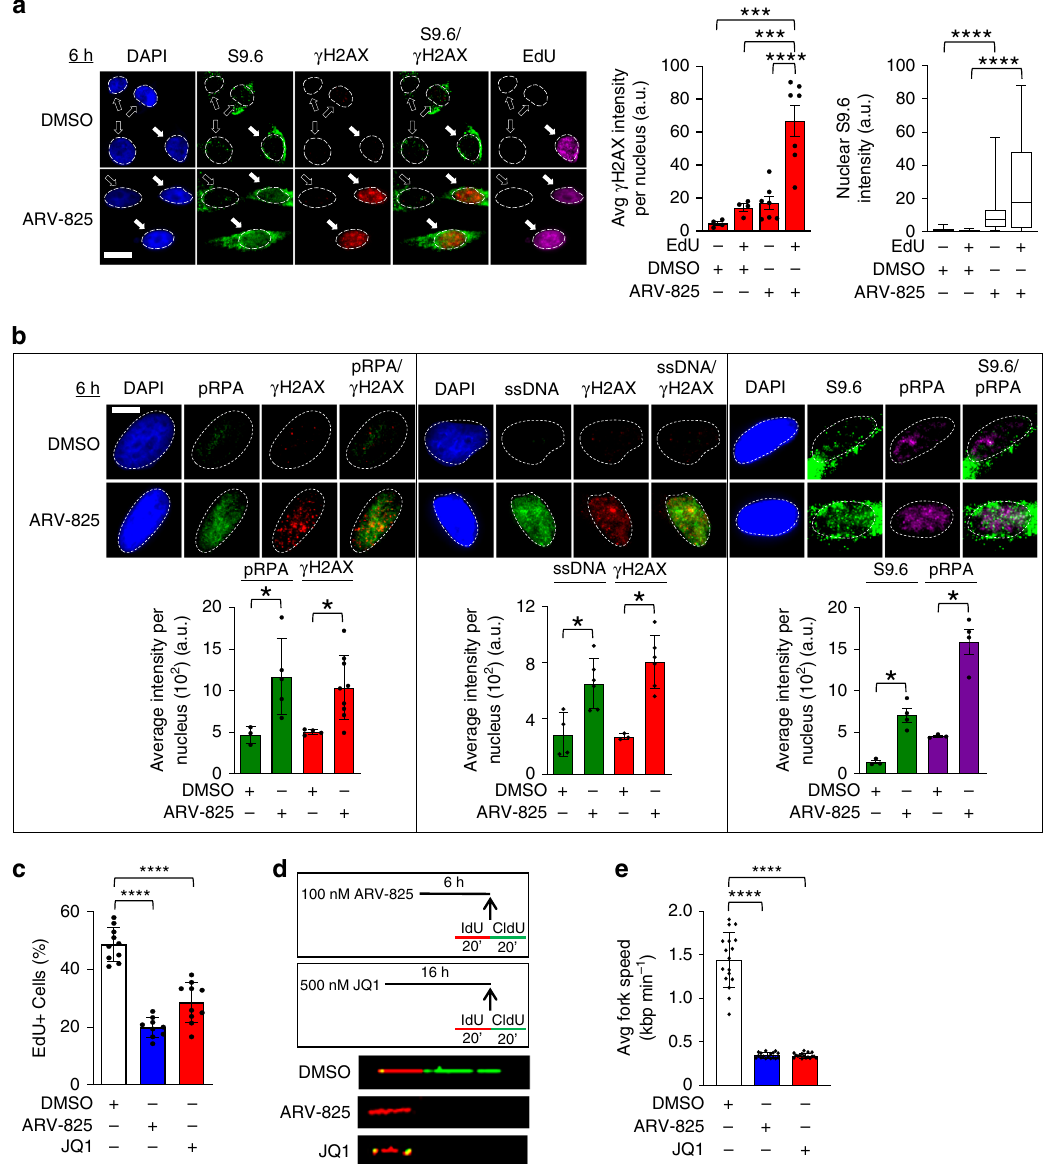
Fig. 8 BRD4 loss causes TRCs and replication fork stalling in S-phase. a IF images and quanti fi cation of γ H2AX and S9.6 intensities per nucleus and EdU incorporation in HeLa cells following treatment with ARV-825 ( n = 3 separate experiments). γ H2AX foci intensity data shown as mean ± SEM. Box-whisker plots for S9.6 intensity drawn as in Fig. 1b. Signi fi cance assessed using ANOVA followed by Tukey ’ s test ( γ H2AX DMSO EdU ( − ) vs ARV-825 EdU ( + ) ****Adjusted P < 0.0001; γ H2AX DMSO EdU ( + ) vs ARV-825 EdU ( + ) ***Adjusted P = 0.0003; γ H2AX ARV-825 EdU ( − ) vs ARV-825 EdU ( + ) ****Adjusted P < 0.0001; S9.6 DMSO EdU ( − ) vs ARV-825 EdU ( − ) ****Adjusted P < 0.0001; S9.6 DMSO EdU ( + ) vs ARV-825 EdU ( + ) ****Adjusted P < 0.0001). Scale bar = 5 μ m. b IF images and quanti fi cation of pRPA2 ser33 (pRPA), γ H2AX, and native BrdU (ssDNA) immuno fl uorescence in cells treated with ARV-825 shown as mean ± SEM ( n = 3 separate experiments). Signi fi cance assessed using two-tailed unpaired t test (* P < 0.05). Scale bar = 2.5 μ m. c Quanti fi cation of the percentage of EdU- positive cells following treatment with DMSO (black), ARV-825 (blue), or JQ1 (red), shown as mean ± SEM ( n = 3 separate experiments). Signi fi cance assessed using ANOVA followed by Tukey ’ s test (DMSO vs ARV-825 ****Adjusted P value < 0.0001; DMSO vs JQ1 ****Adjusted P value < 0.0001). d Experimental scheme for DNA fi ber combing experiments. Fluorescent images of DNA fi ber combing following treatment with either DMSO, ARV-825, or JQ1. Representative examples of normal replication, fork stalling, and stalling re-start, respectively, are shown. e Quanti fi cation of fork speed performed following treatment with DMSO (black), ARV-825 (blue), or JQ1 (red). Mean ± SEM from n = 3 separate experiments is shown. Signi fi cance assessed using ANOVA followed by Tukey ’ s test (DMSO vs ARV-825 ****Adjusted P value < 0.0001; DMSO vs JQ1 ****Adjusted P value < 0.0001). Source data are provided as a Source data fi